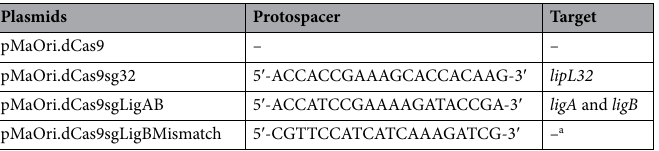
Table 1. Plasmids and protospacers composing the sgRNA and specificity. a Designed for L. borgpetersenii